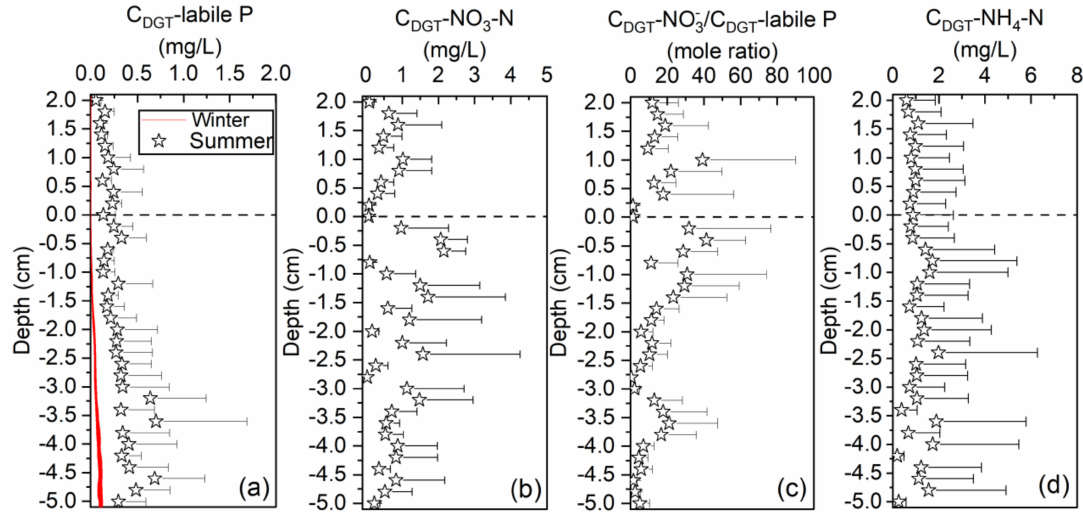
Figure 4. The concentrations of labile P at SWI in winter ( a ), labile P concentrations ( a ), NO 3 − -N concentrations ( b ), NO 3 − -N: labile P mole ratio ( c ), and NH 4+ -N concentrations ( d ) at SWI in